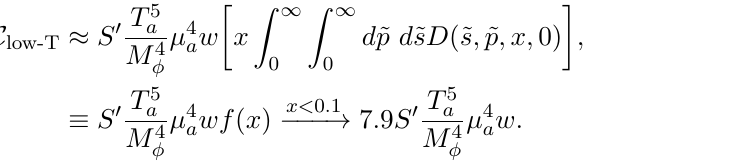
Figure 14. Left Panel: total energy transfer collision term (cid:22) C E = C E =M 5 at (cid:12)xed temperature ratio x = T b =T a = 0 : 5. The black solid line corresponds to C E numerically evaluated using eq. (C.12) with matrix element given in eq. (C.14), red dashed line corresponds to C high-T (eq. (C.22)), purple dashed line corresponds to C MB (eq. (C.23)) and the blue dashed line corresponds to C low-T (eq. (C.25)). Right Panel: the ratio of the analytic approximation to C E (eq. (C.26)) with the full numerical value as a function of T a =M (cid:30) for x = 0 : 99 ; 0 : 5 ; 0 : 001. Results are shown for (cid:22) a = 0 : 01 M (cid:30) , (cid:22) b =(cid:22) a = 0 : 5, and m a;b = 10 (cid:0) 8 M (cid:30)